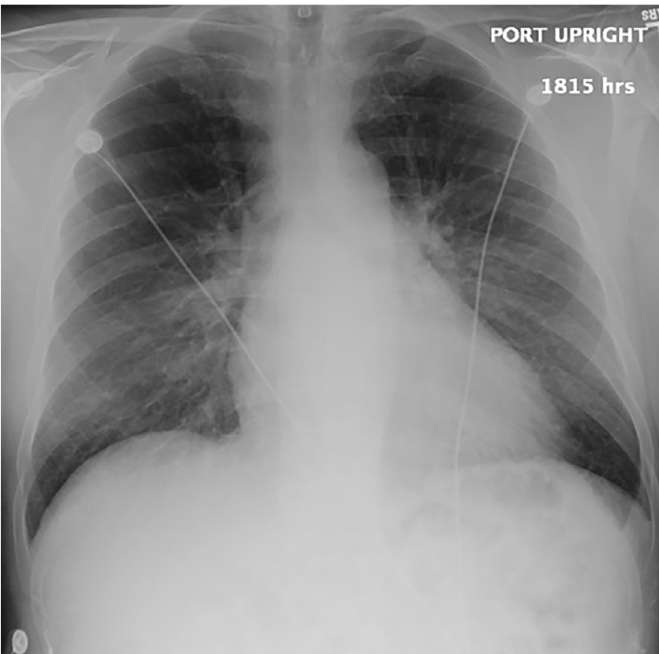
Image 2. Anterior-posterior chest radiograph of a 55-year-old male with palpitations and